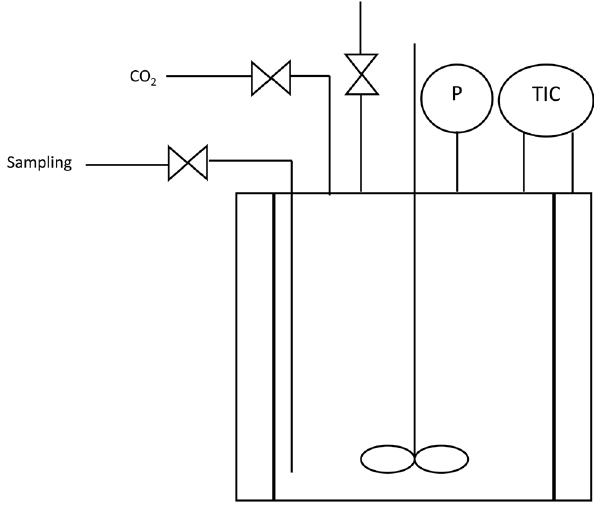
Figure 2: Scheme of the reactor used for the